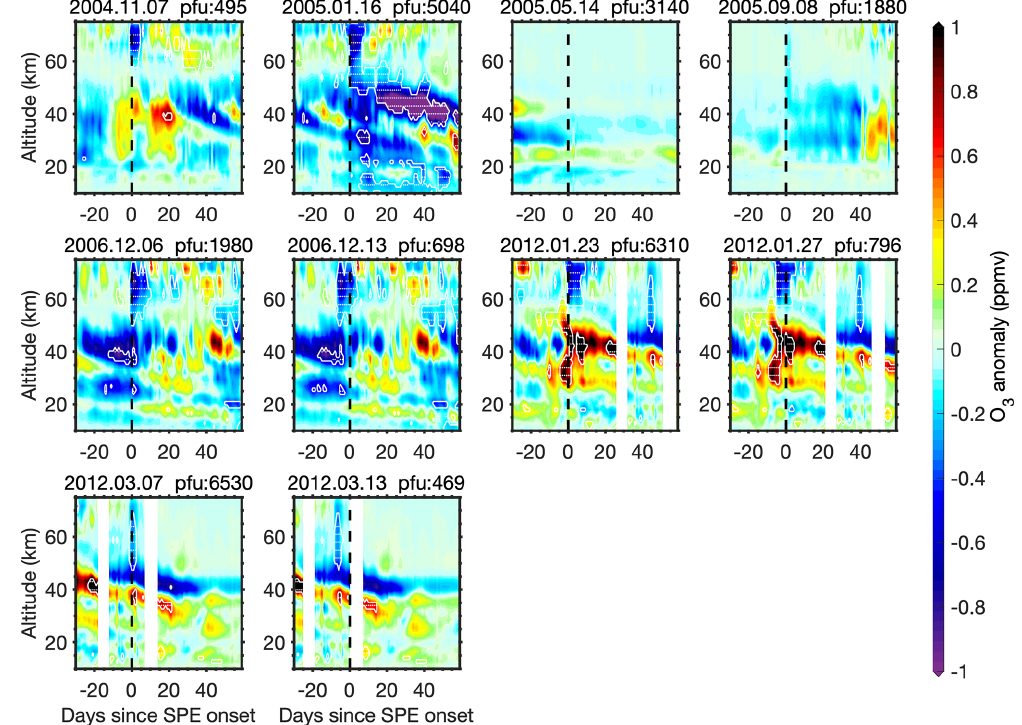
Figure 4. Same as Fig. 3 but for ozone anomalies from WACCM-D simulation at MLS measurement time and location.